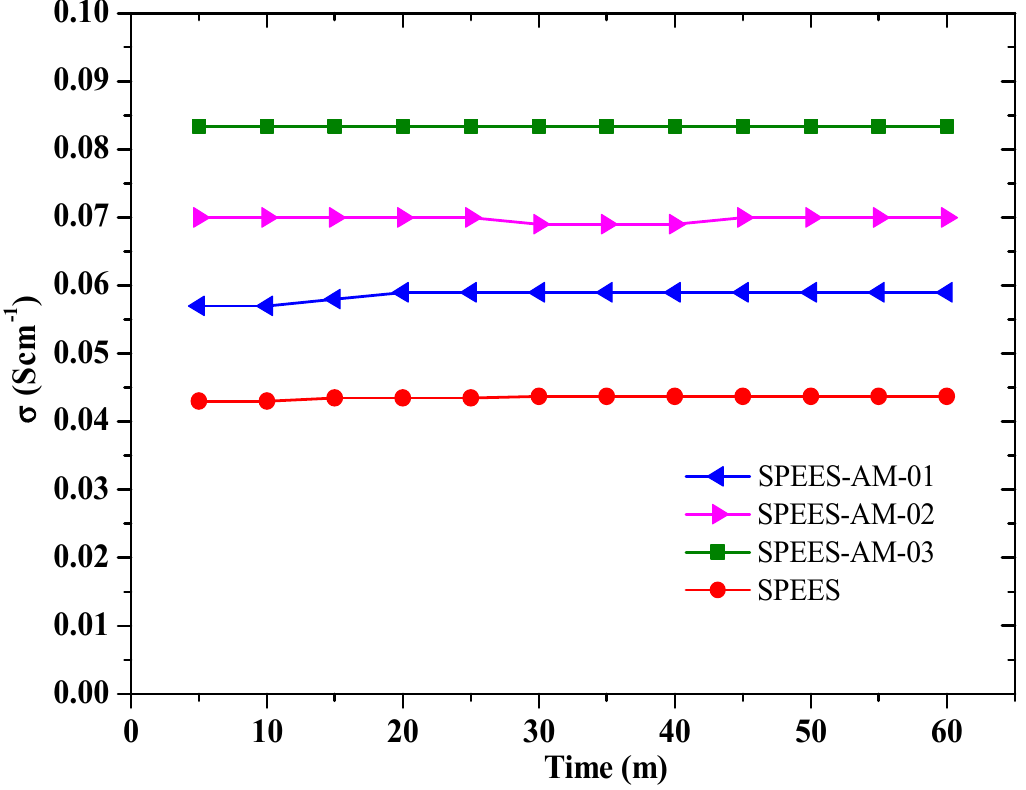
Figure 11. Proton conductivity of SPEES and SPEES-AM membranes at 45 °C for an hour after acid stability.